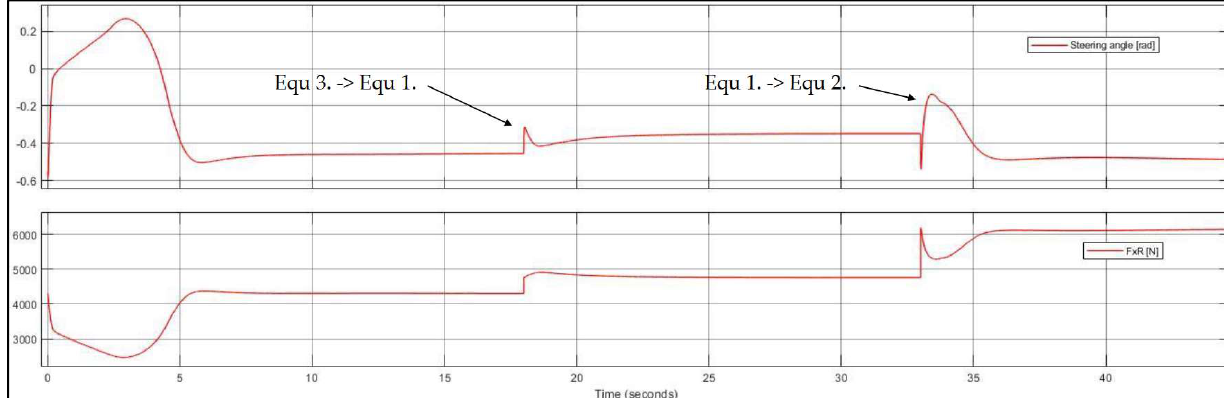
Figure 10. Control inputs during the test while reaching the targeted three different equilibria.